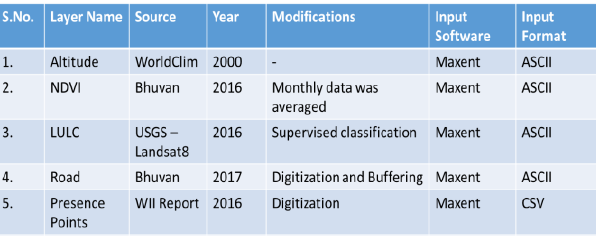
Figure 8 – Summary of inputs used